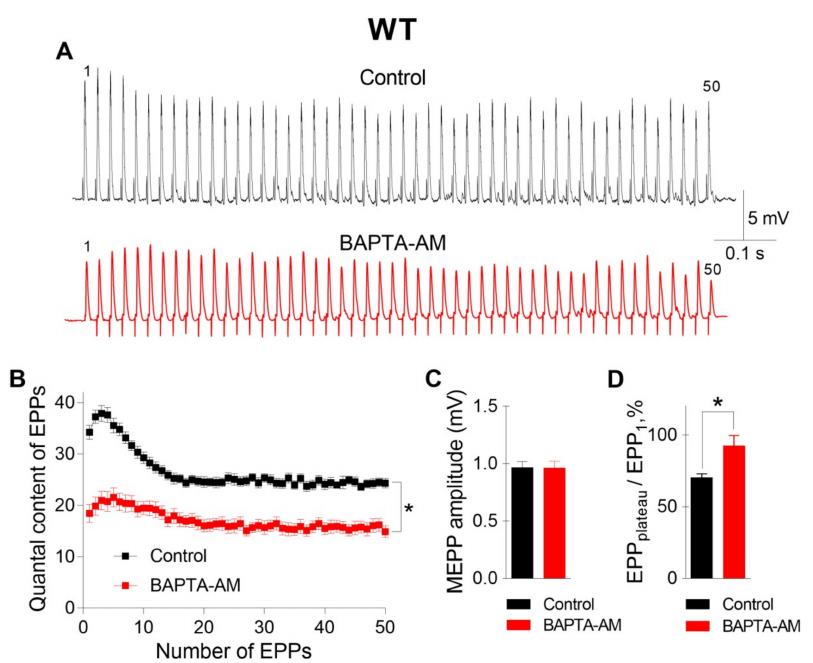
Figure 2. BAPTA-AM induced the downregulation of evoked neuromuscular transmission at the NMJs of WT mice during a short high-frequency train (50 Hz, 1 s). ( A ) Representative recordings of EPPs in the control group (top) and after incubation with BAPTA-AM (bottom). ( B ) Changes in the EPP quantal content in the control group (n = 16) and after incubation with BAPTA-AM (n = 17). ( C ) MEPP amplitude in the control group and after incubation with BAPTA-AM. ( D ) The ratio of the average quantal content of the last ten EPPs in the train to the quantal content of the first EPP (EPP plateau / EPP 1 ) normalized to EPP 1 (taken as 100%) in the control group and after incubation with BAPTA-AM. The symbols, histograms and error bars represent the mean ± SEM. * p <